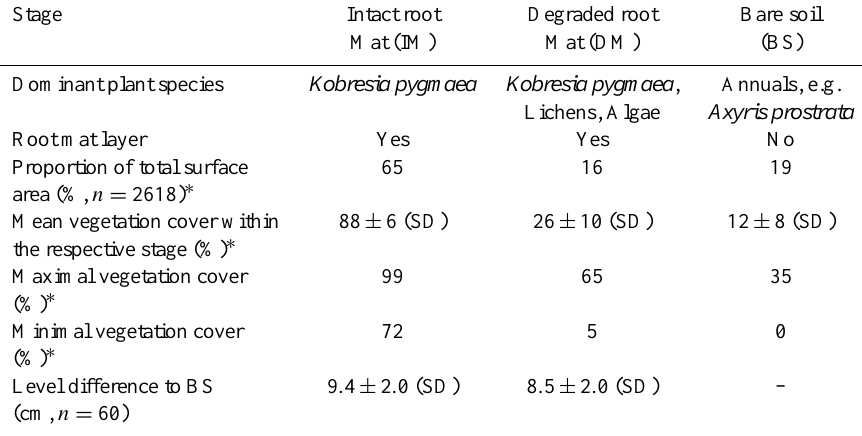
Table 2. Criteria for a differentiation of main degradation classes at Kema site and survey